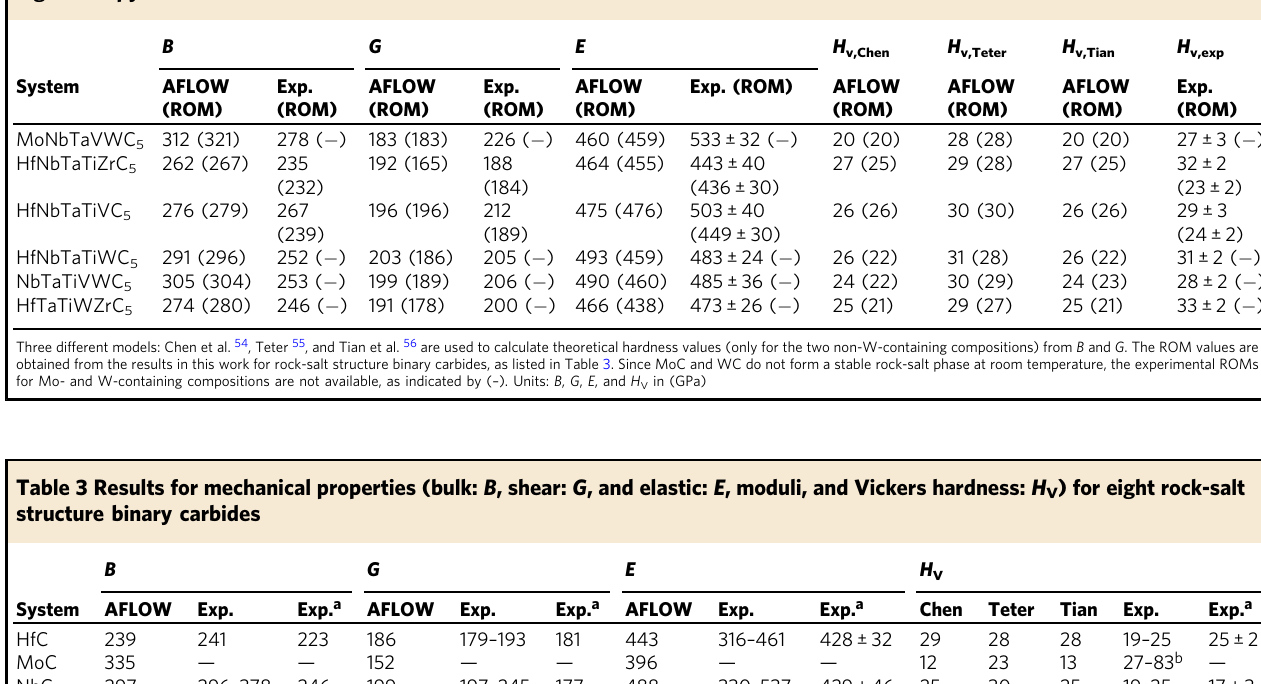
Table 2 Results for mechanical properties (bulk: B , shear: G , and elastic moduli: E , and Vickers hardness: H V ) for six single-phase high-entropy carbides